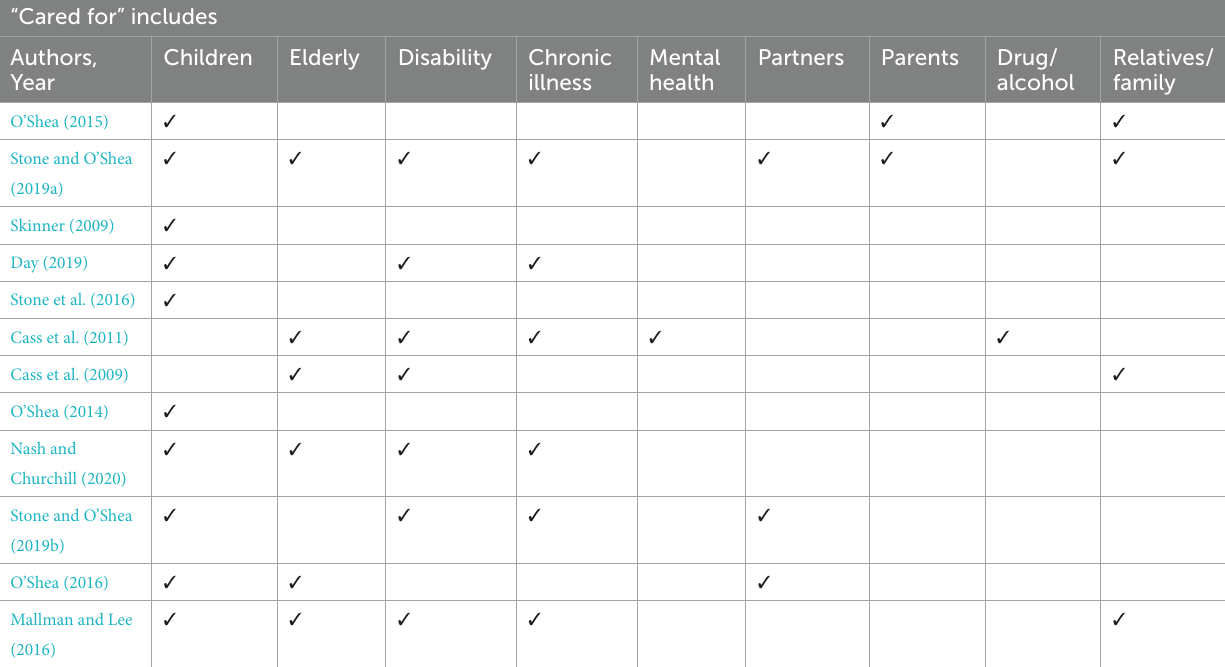
TABLE 3 Who is cared for? “Cared for”